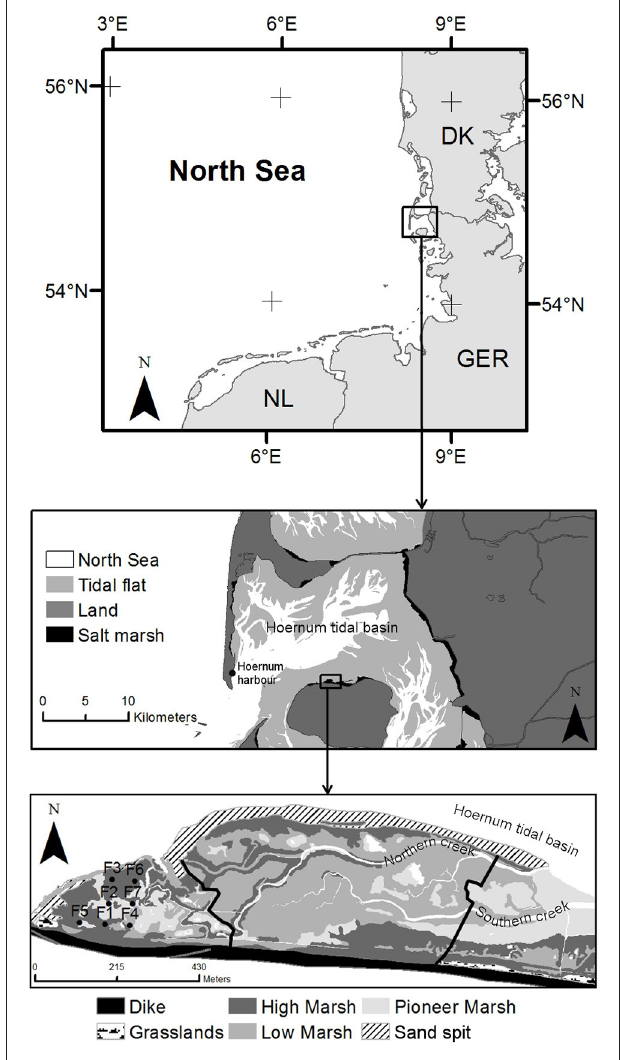
FIGURE 1 | Location of the study area (Oldsumer foreland) along the North Sea coast of Germany. The salt marsh is located in the north of the island of Foehr. Sediment cores (F1 to F7) have been extracted in the western, mature part of the marsh (black dots), southwest of where the overwash breach in the sand spit is located. The vegetation zonation within the study site is aggregated from the TMAP database (Trilateral Monitoring and Assessment Programme, 2007). Vegetation characteristics considerably differ between the western, central, and eastern part of the marsh as defined by the black